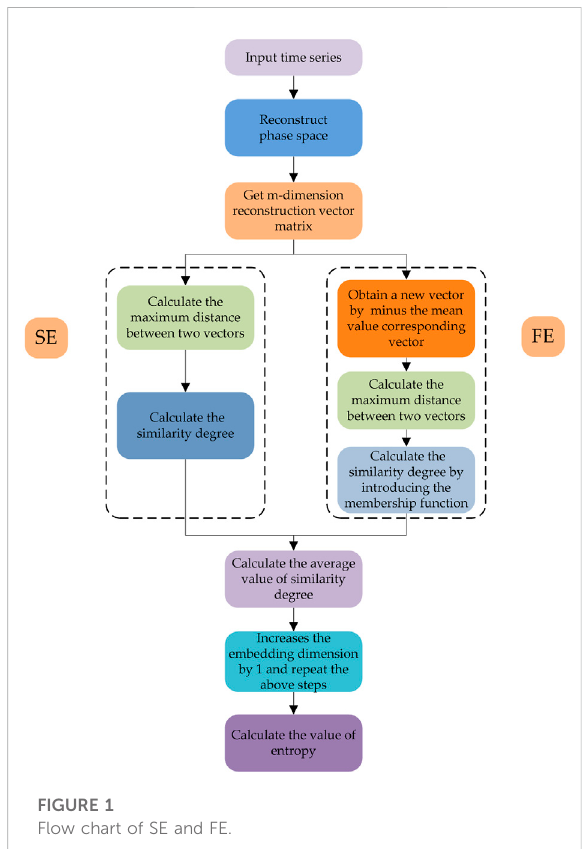
FIGURE 1 Flow chart of SE and